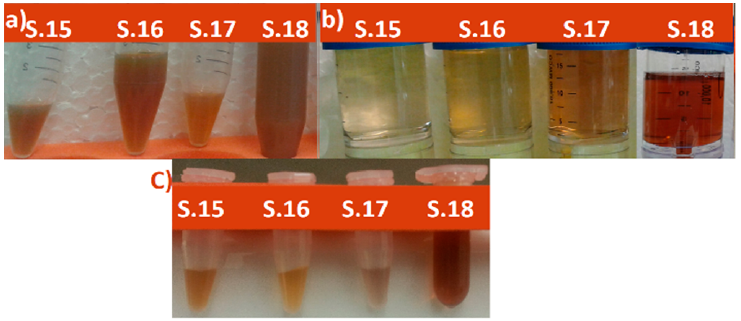
Figure 1. Images of the some samples ( a ) immediately after preparation ( b ) when washed using Vivaspin 10 kDa and ( c ) after washing. S mean sample Number.